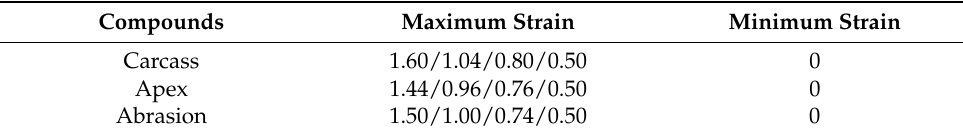
Figure 6. Δ SED–N f curve of apex. Figure 7. Δ SED–N f curve of abrasion.